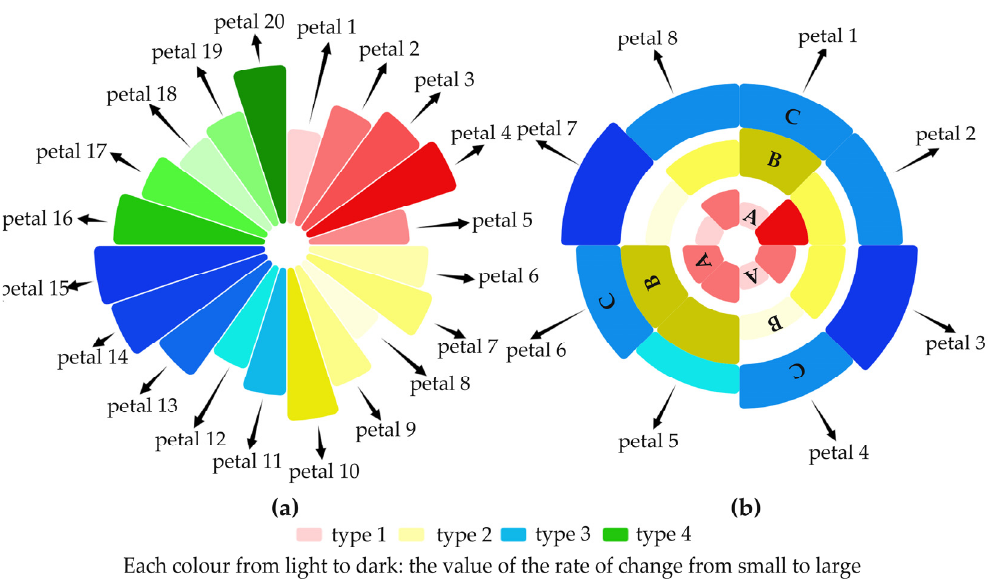
Figure 1. Examples of the proposed method. ( a ) Multidimensional rose chart. ( b ) Stacked multidi- mensional rose chart.